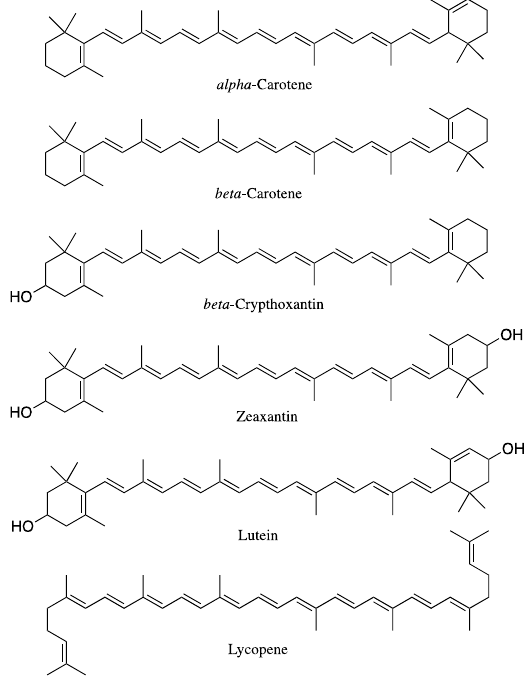
Figure 1. Chemical structures of relevant carotenoids.